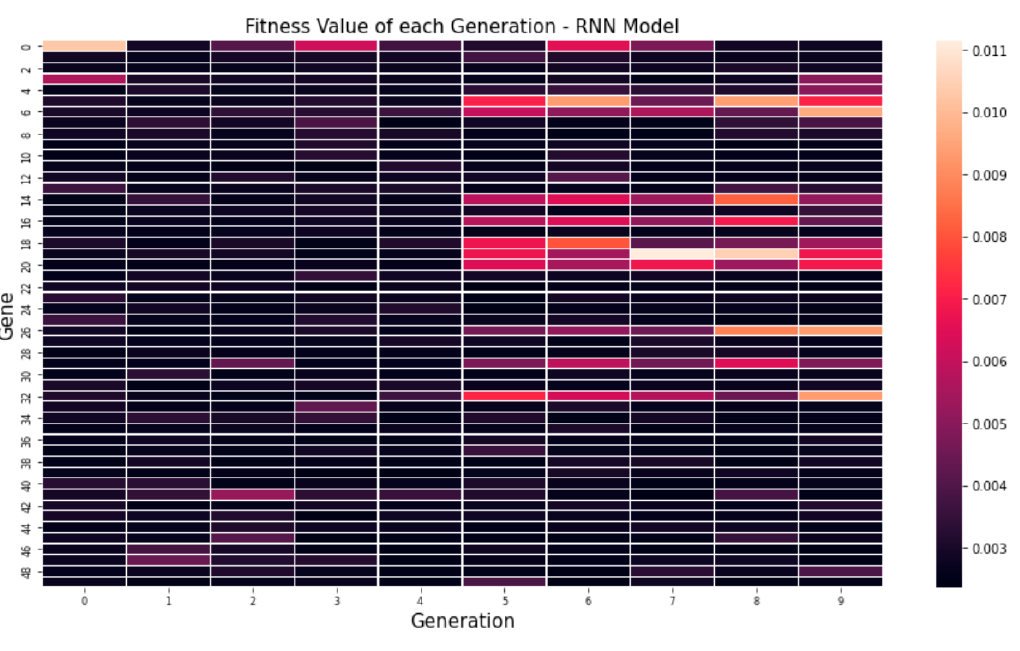
Figure 5. Minimum, maximum and average values of the fitness function for each generation.